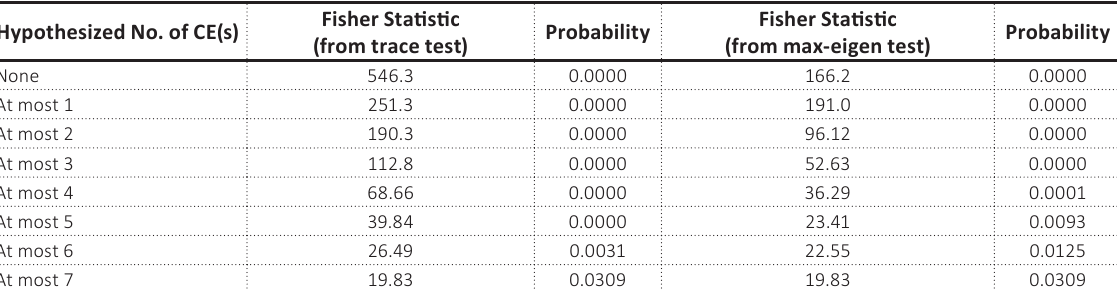
Table 5. Johansen-Fisher panel co-integration test